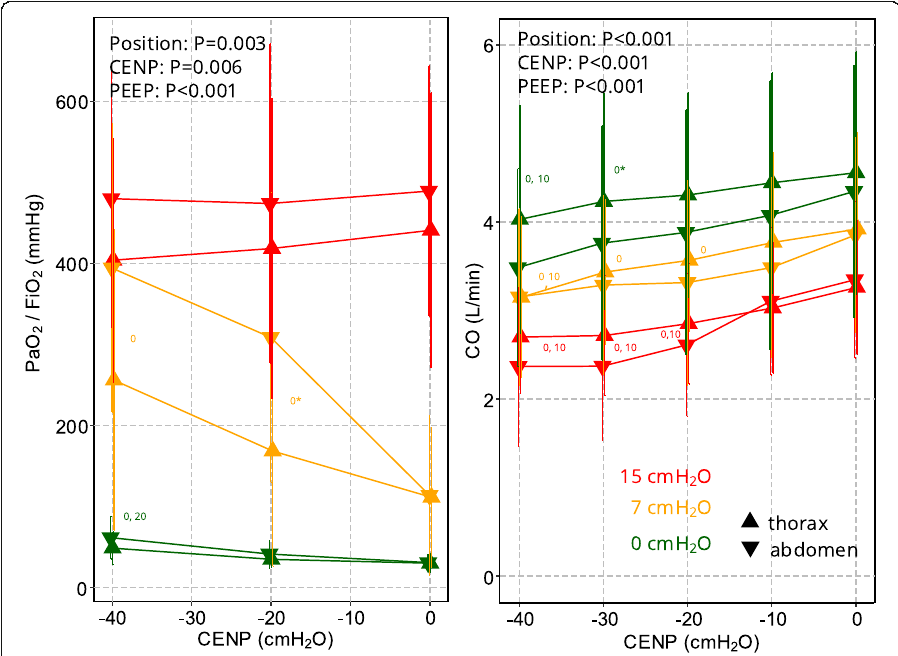
Fig. 4 Centre of aeration (left) and centre of ventilation (right) as a percentage from dorsal. Legend: CENP, continuous external negative pressure; PEEP, positive end-expiratory pressure. Triangles indicate different shell positions (abdomen and thorax), colours represent different PEEP levels, super-posed numbers indicate significance ( P < 0.05) of the respective CENP level compared with the CENP level of the number and stars indicate the difference between both